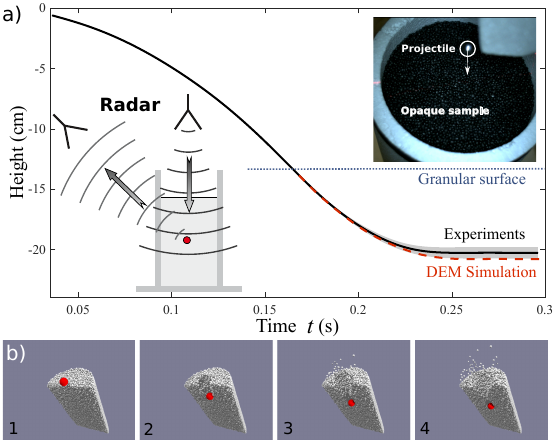
Figure 5: (a) The trajectory of a spherical metallic tracer impacting onto opaque Styrofoam particles (see upper right inset for a snapshot of the sample) obtained with a radar setup (see lower left inset for a schematic of the setup) together with the result from numerical simulations. Gray shaded region corresponds to the uncertainty of the trajectory based on multiple runs of experiments. (b) Projectile (red) impact on a granular material composed of spherical particles (silver). Data extracted from the DEM simulation of a corresponding experiment